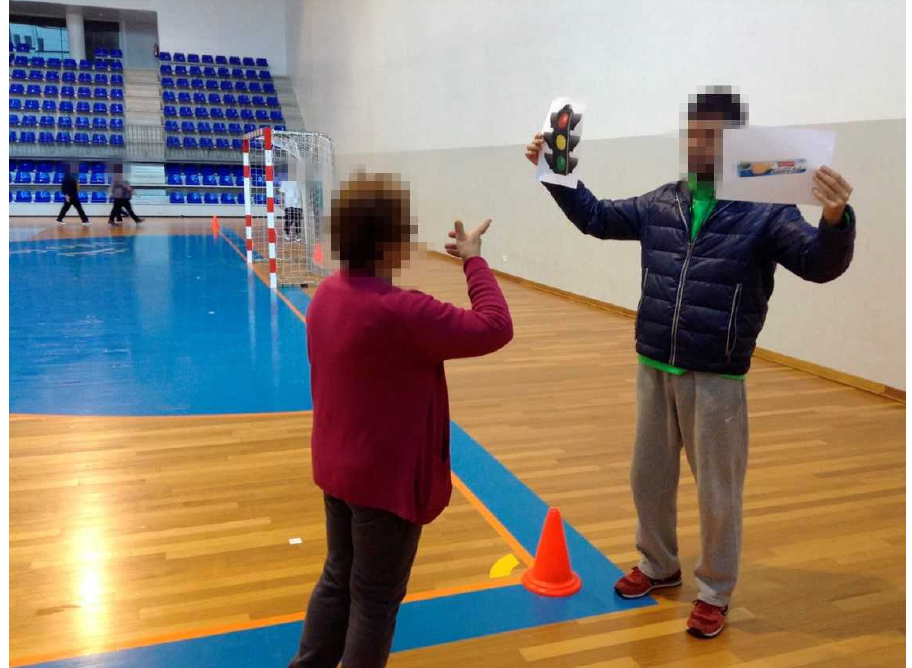
Figure 4. Traffic light system (individual response) during walking exercise: green color—best food choices; yellow color—choose carefully; red color—foods to avoid.